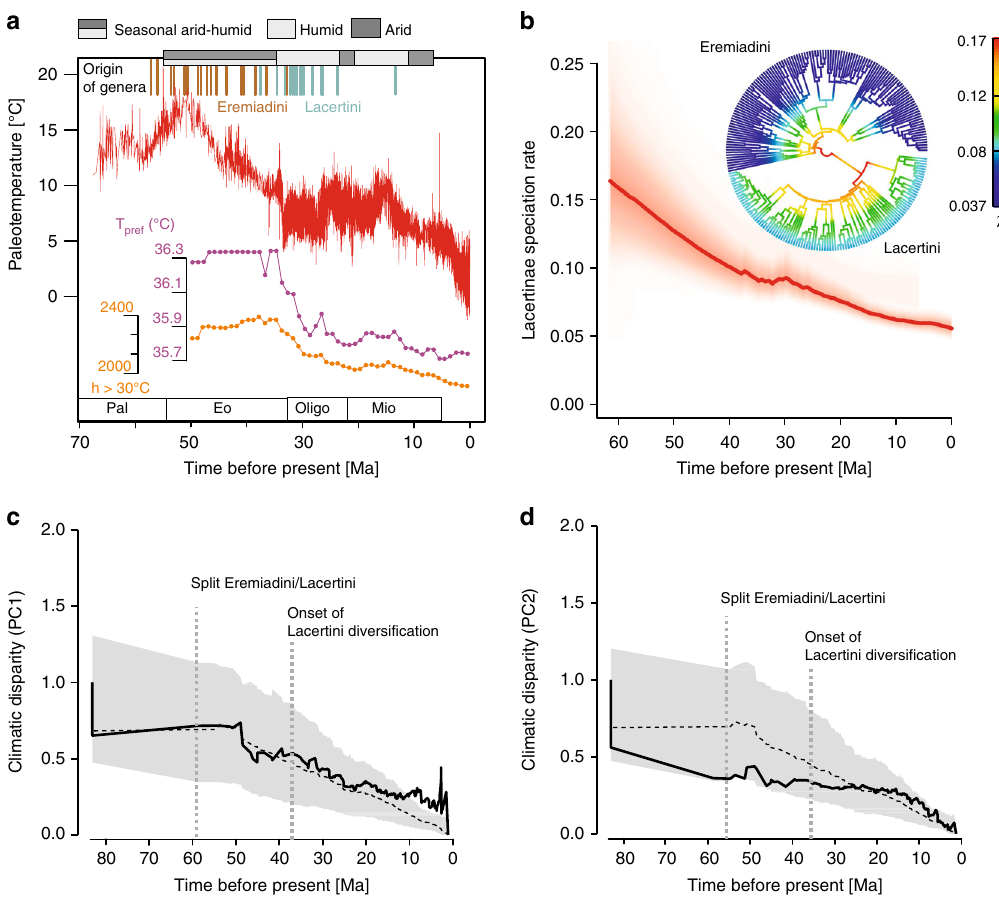
Fig. 3 Associations between paleoclimate and lacertid diversi fi cation. a Paleoclimatic reconstructions of temperature (red graph) and humidity (top bars) during diversi fi cation of the Lacertinae (Eremiadini + Lacertini); splits among genera within the two tribes shown as brown and blue lines. Orange and purple inset lines show trend of phylogenetically reconstructed T pref and thermal niche (yearly hours >30 °C), averaged over all lineages existing at a certain time as in Fig. 1a and Supplementary S13. b BAMM-estimated speciation rates through-time plot and best- fi t model of speciation rates plotted on circle tree of Lacertinae. Color density in red shading denotes con fi dence on diversi fi cation rate reconstructions at any point in time. c , d Plots of climatic disparity through-time (DTT), for the fi rst and second principal components (PC1/PC2) of a phylogenetic principal component analysis (PPCA) of seven bioclimatic variables across lacertids, showing an increase of climatic disparity in PC1 around 45 ‒ 30 Ma that coincides with the onset of Lacertini diversi fi cation. The dashed line indicates the median subclade DTT based on 1000 simulations under a Brownian motion model. The gray shaded area indicates the 95%